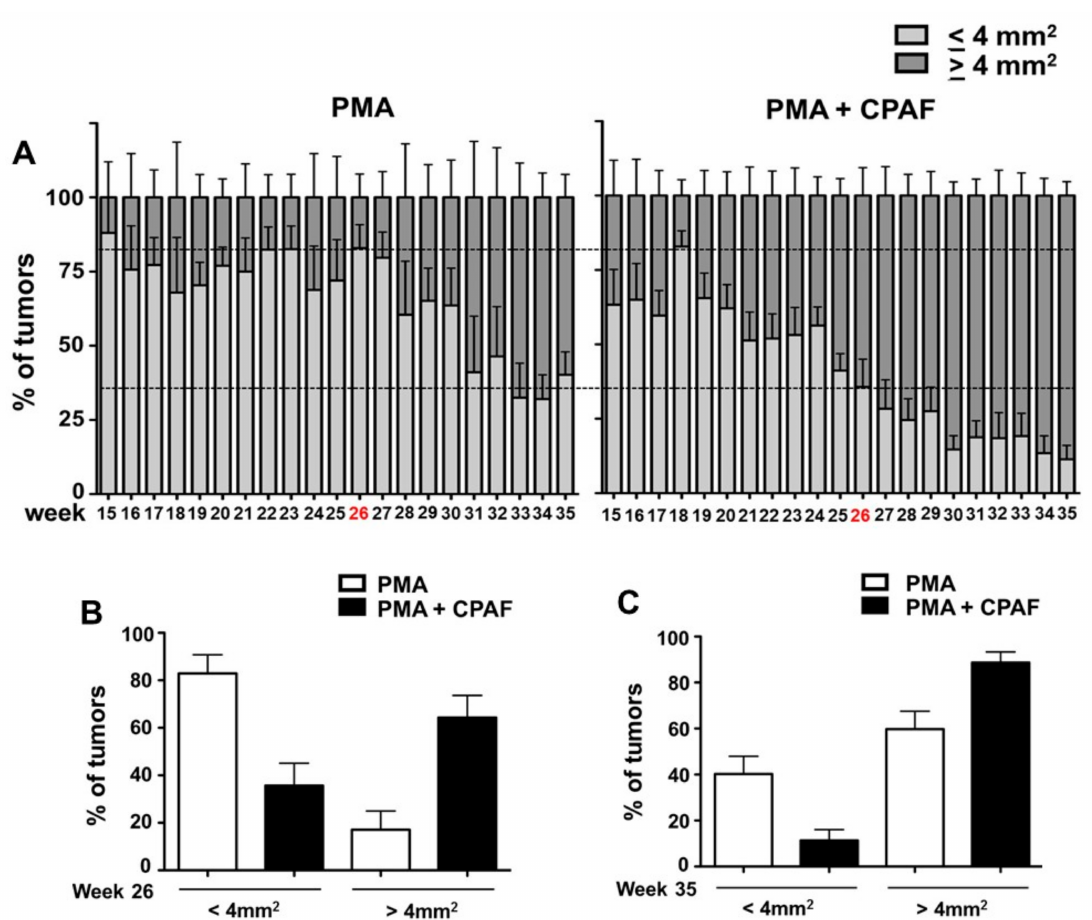
Figure 2. Effect of systemic CPAF on the invasiveness/durability of DMBA/PMA-induced tumors. ( A ) PMA treatment was stopped at week 26 (red color), and CPAF treatment continued for up to 35 weeks. Percentage of tumors of ≤ 4 mm 2 (light gray color bar) or ≥ 4 mm 2 (dark gray color bar) in PMA and PMA + CPAF treated groups of mice are shown. ( B , C ) Percentage of all tumors in PMA and PMA + CPAF groups at week 26 and 35 are